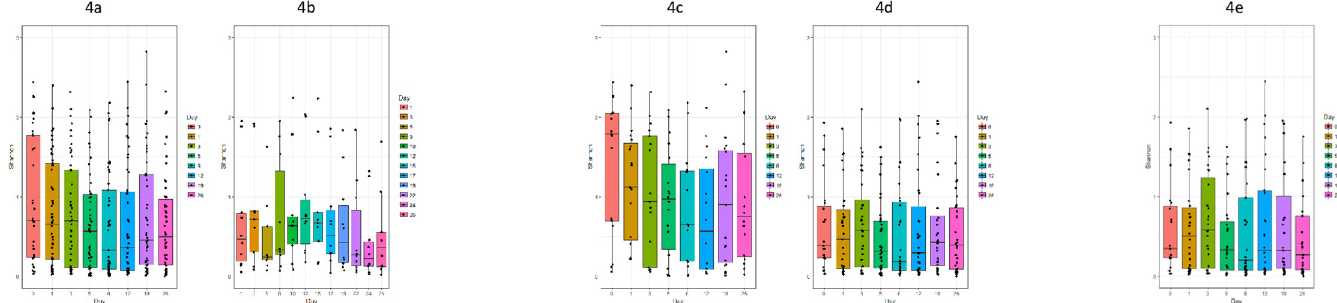
Fig 4. Boxplot of Shannon diversity index given per sampling. a: All patients. b: All controls. c: Patients treated with metronidazole. d Patients without metronidazole treatment. e: Patients initially positive for C . trachomatis or M . genitalium and not treated with metronidazole.